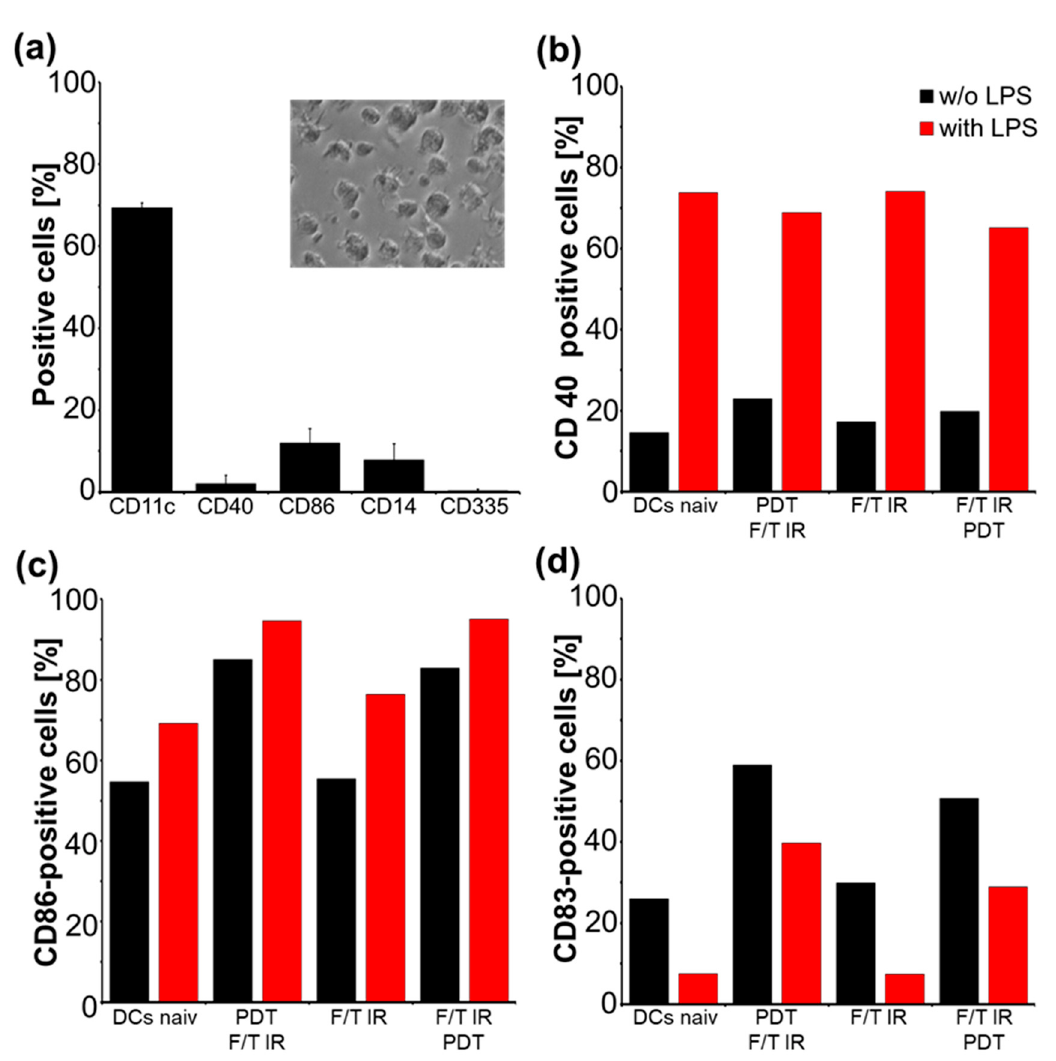
Figure 2. Differentiation and maturation of DC. ( a ) Quantification of DC (CD11c), monocytes (CD14), natural killer cells (NK, CD335) and number of CD40-, CD86-positive, activated DCs, n = 3; phase contrast image of differentiated DCs, original magnification: 40 × ; ( b ) Effect of GL261 lysate, cell antigen preparation and LPS activation on CD40; ( c ) on CD86; and ( d ) on CD83 expression in CD11c-positive DCs, flow cytometry (FC) analysis, one representative experiment of two.